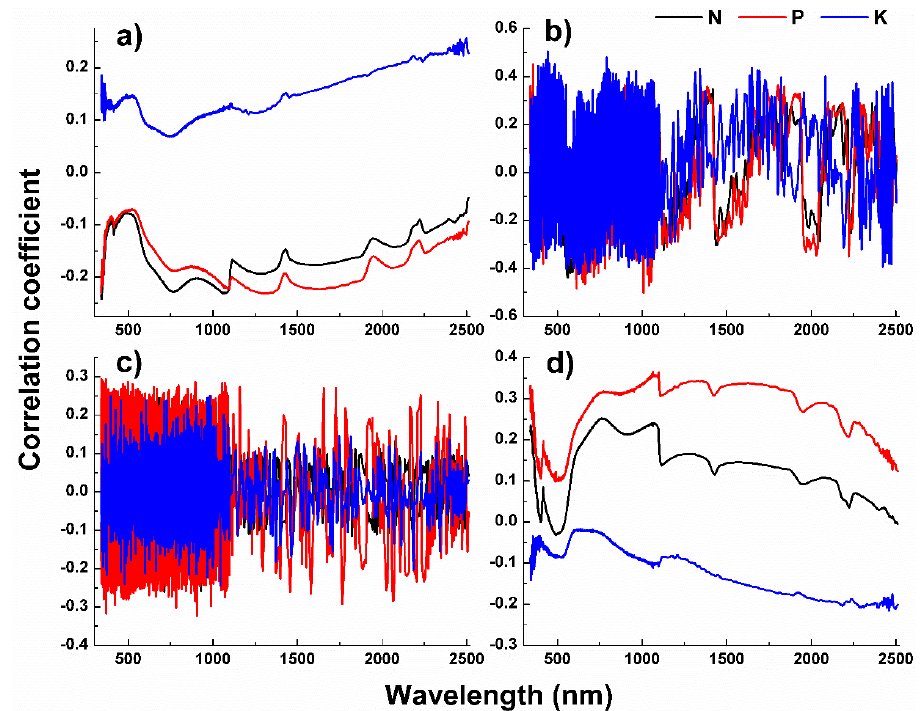
Figure 6. Pearson correlation coefficients between soil nutrient contents and four spectral indices: ( a ) raw spectral reflectance; ( b ) first derivative; ( c ) second derivative; and ( d ) reciprocal logarithmic. Table 2. The optimal spectral variables selected for prediction of three soil nutrients Soil Nutrient The Spectral Variables Correlation Coefficients